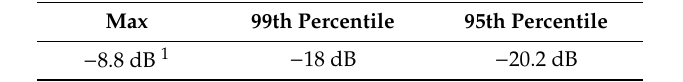
Figure 5. Envelope of EIRP act (dB), i.e., max t 𝐸𝐼𝑅𝑃 act (𝜑,𝜃,𝑡)) in the azimuth plane (in red) for the BS having the largest observed 𝐸𝐼𝑅𝑃 act . The values are normalized to the peak EIRP. The green dashed line shows the envelope of the (normalized) EIRP assuming constant peak power transmission for every beam. Table 1. Maximum, 99th percentile and 95th percentile of 𝐸𝐼𝑅𝑃 act with respect to the envelope of the theoretical maximum for all 25 BSs within 24 h. For each BS and for each time t , EIRP act was considered in the angular direction providing the smallest di ff erence with respect to the theoretical